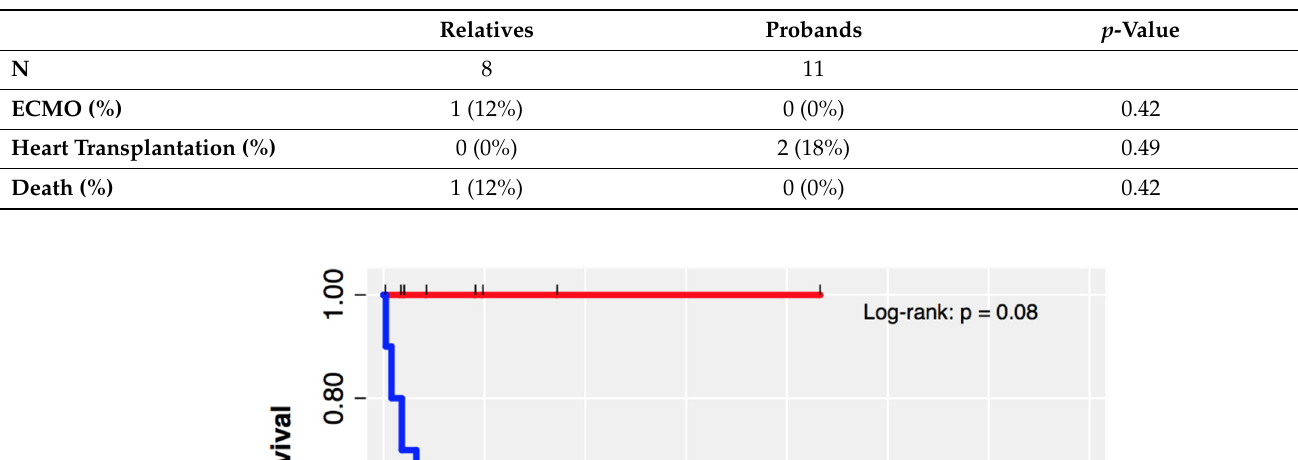
Table 6. Clinical outcomes of 19 probands and relatives with pathogenic or likely pathogenic variants in the desmoplakin gene ( DSP ). Abbreviations: ECMO = extracorporeal membrane oxygenation.